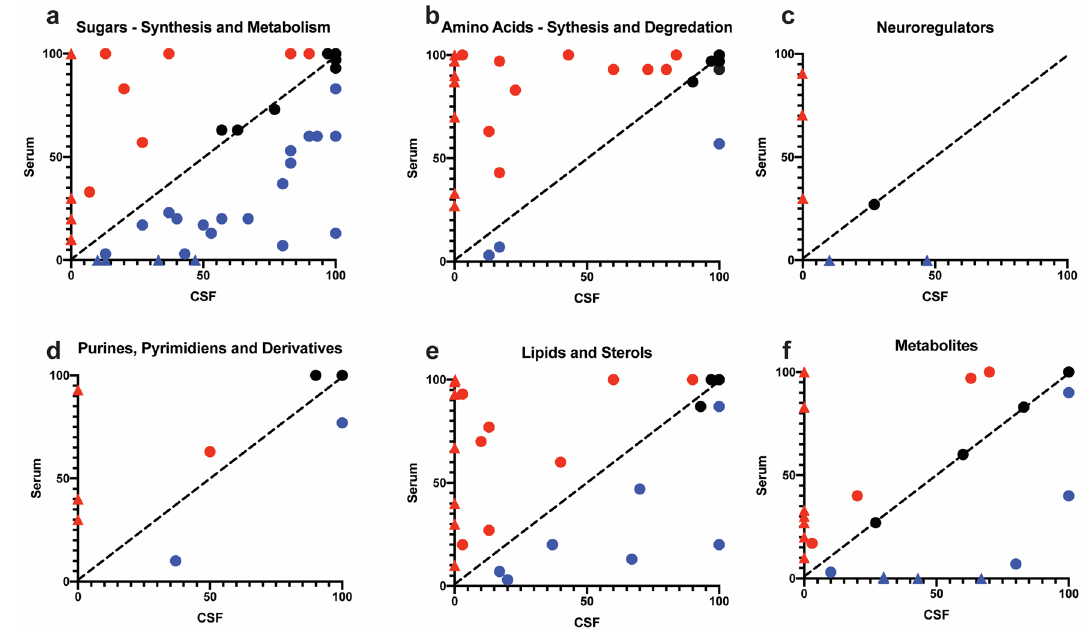
Figure 5. Plots of major classes of identified metabolites, compounds in greater abundance in serum (red circles), exclusively in serum (red triangles), compounds in greater abundance in CSF (blue circles), exclusively in CSF (blue triangles), and compounds in equal (within 5%) abundance (black circles). The black dashed diagonal line represents equal intensities. ( a ) Carbohydrate (sugar) monomers associated with synthesis and metabolism as well as artificial sweeteners. ( b ) The 21 natural amino acids were all detected, amino acid derivatives, and metabolites associated with protein degradation. ( c ) The neuroregulators detected were primarily in serum or CSF. d) Purines, pyrimidines, and their derivatives that make up the nucleosides in DNA and RNA. ( e ) Low molecular weight lipids were detected primarily in serum over CSF. ( f ) Other metabolites that includes urea cycle products, food and drug